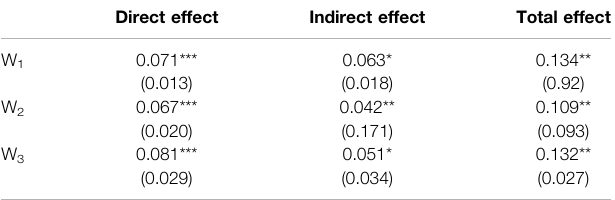
TABLE 6 | Regression results of SDM. TABLE 7 | Decomposition of spillover effect of